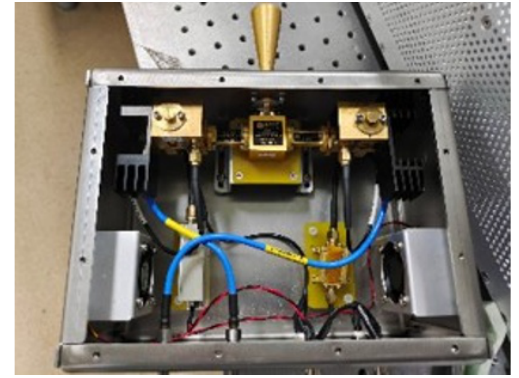
Figure 2. CECE RF unit with two LOs and